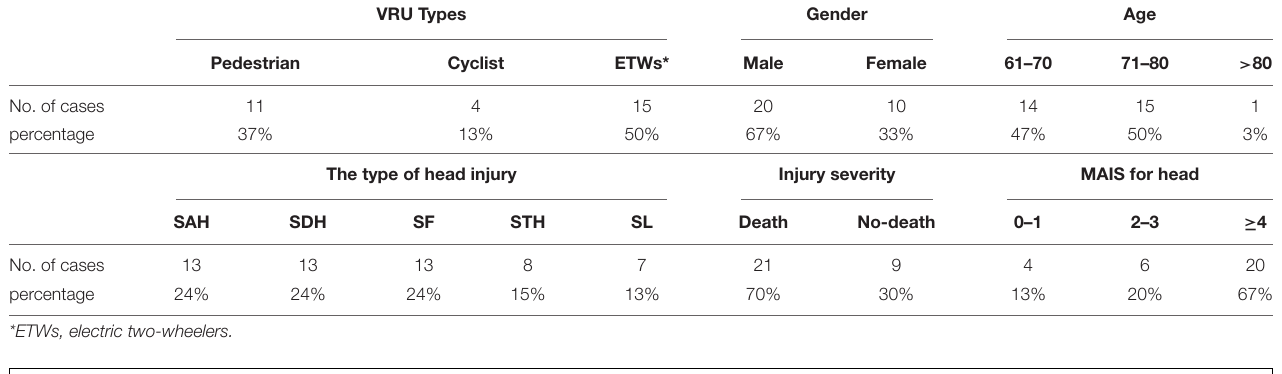
TABLE 1 | Basic information of 30 accidents.